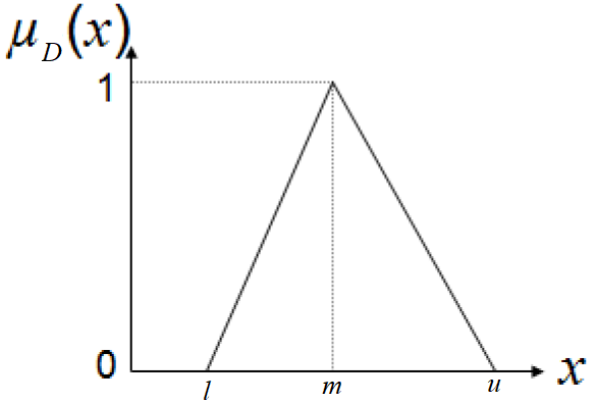
Figure 2. Triangular membership function